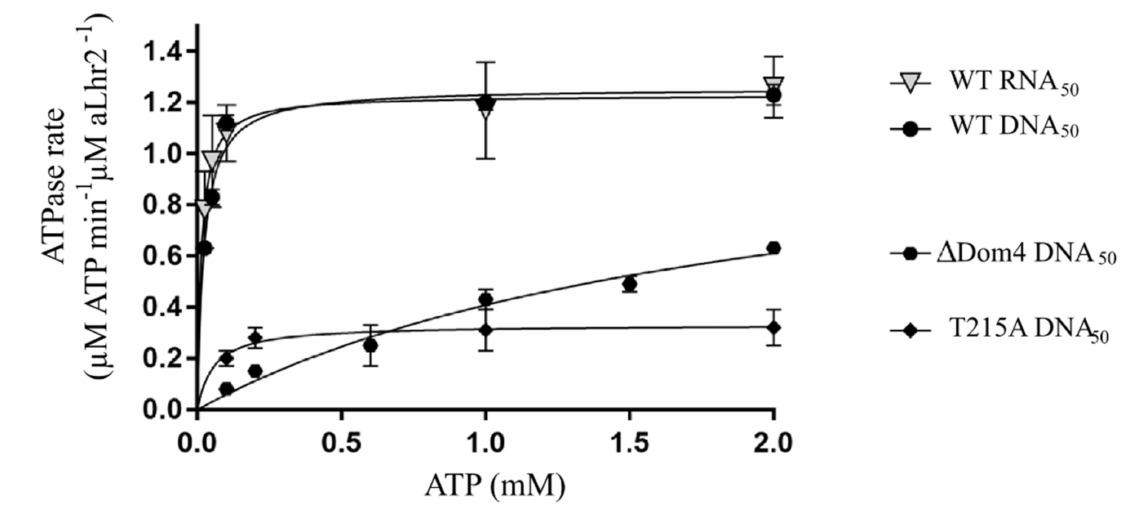
Figure 5. ATPase activity of wild-type Tbar -aLhr2 and of ∆ Dom4 and T215A derivatives in the presence of nucleic acid molecules. The apparent Michaelis dissociation constant (Km) of Tbar -aLhr2-WT for the DNA 50 and RNA 50 molecules are 23 ± 1 µ M and 13 ± 1 µ M, respectively. See also Supplementary Figure